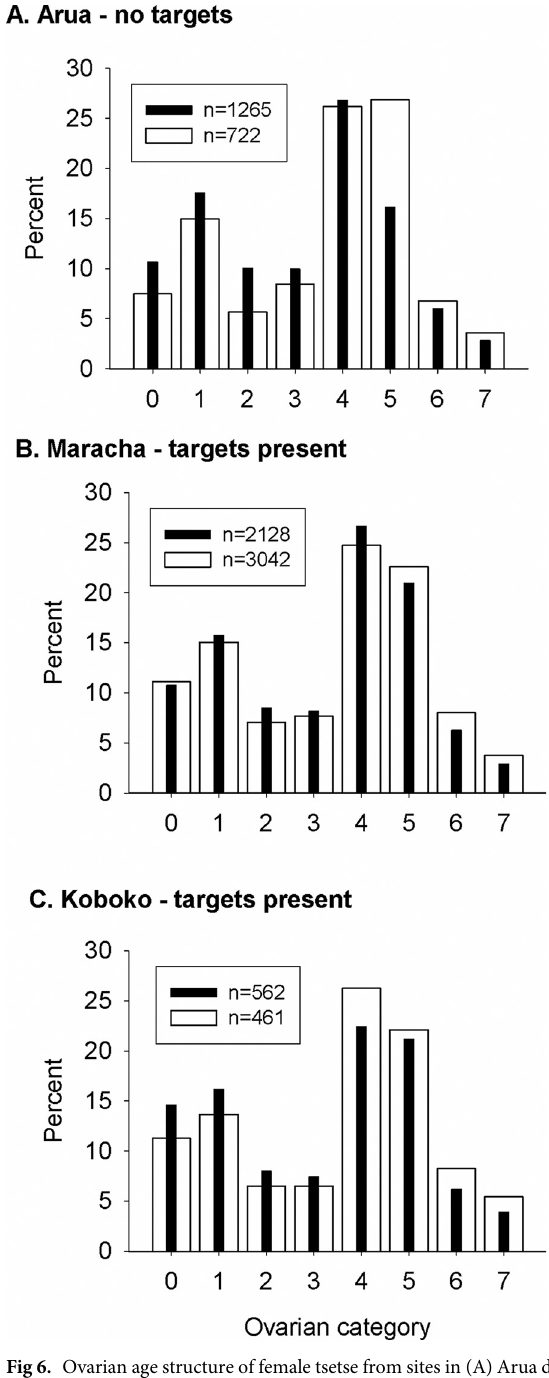
Fig 6. Ovarian age structure of female tsetse from sites in (A) Arua district where targets were absent, or (B) Maracha and (C) Koboko districts where they were present. Solid and open bars show data for 2015 and 2016 respectively.